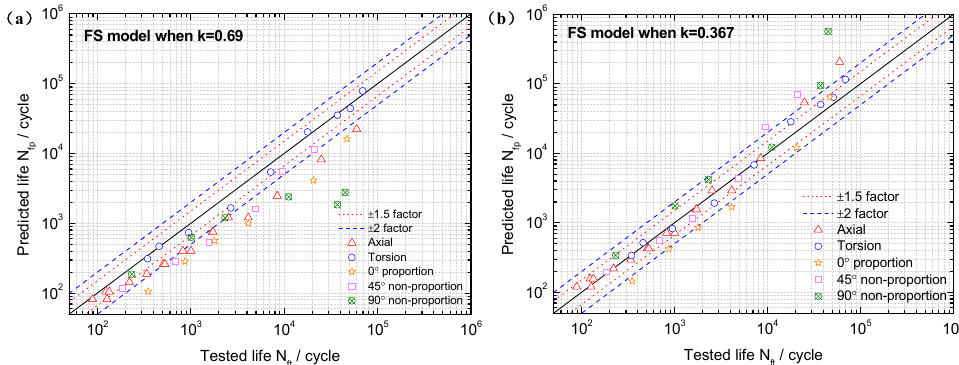
Figure 2. Comparison between tested lives and predicted lives using the Fatemi–Socie (FS) model when ( a ) k = 0.69 and ( b ) k = 0.367 for TC4 under symmetric loadings.